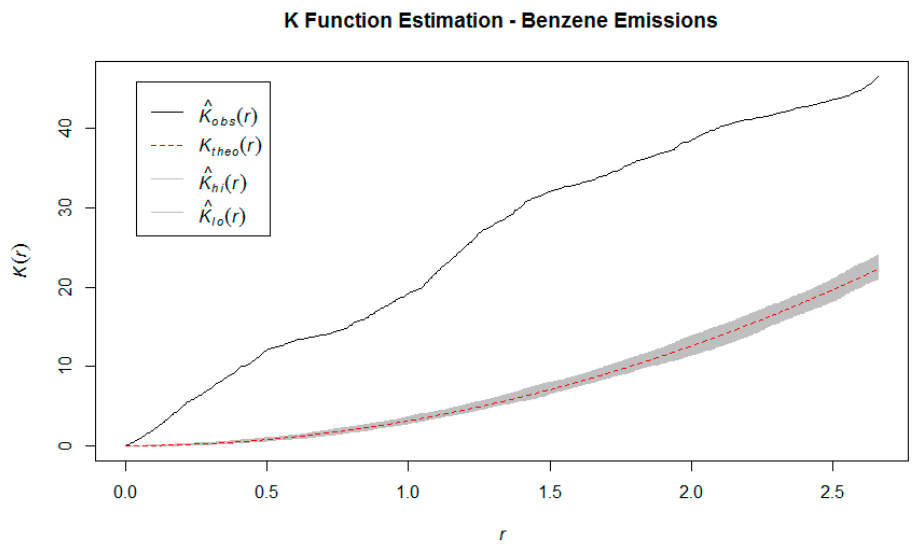
Figure 3. K function estimation benzene emission sites.